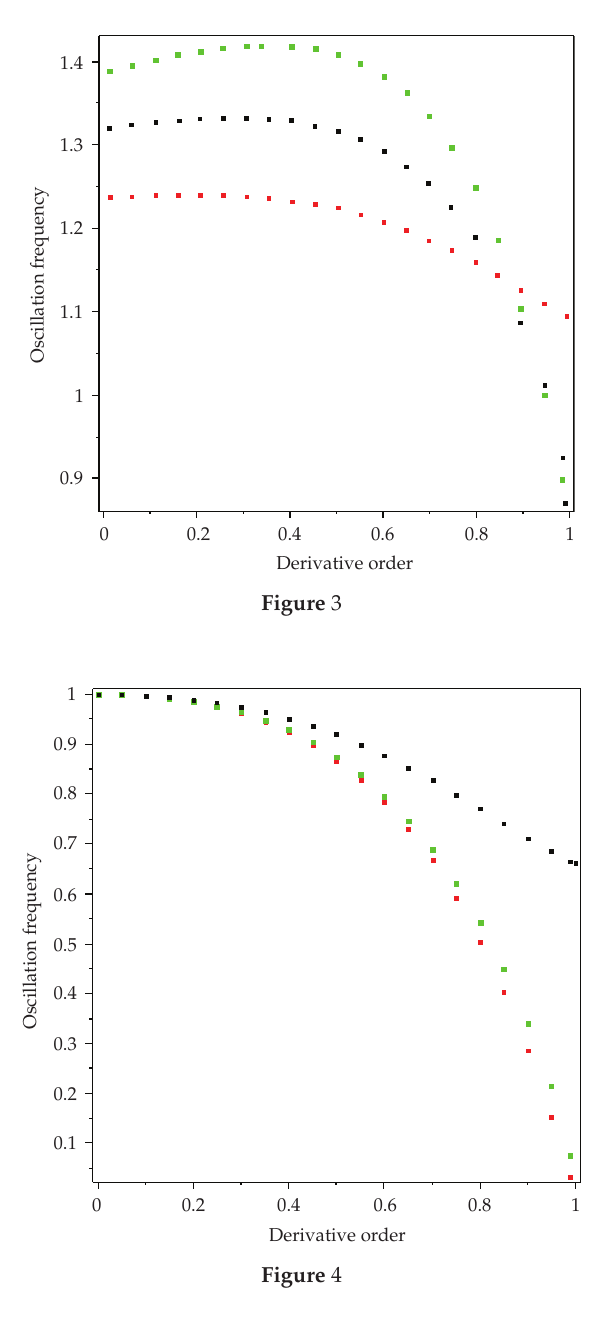
√ 2, and the black